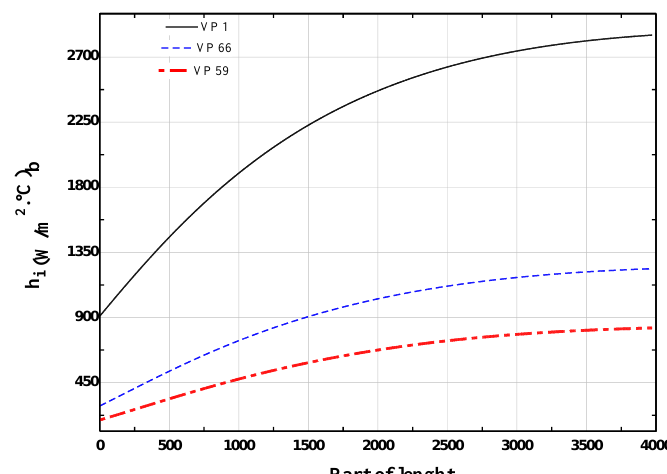
Figure 7. Inside heat transfer coefficient vs. pipe segment for different thermal oils Sum of heat losses during pipe segments is shown in Figure 8 for different oils. THERMINOL VP1 has the maximum heat loss rather than the others.